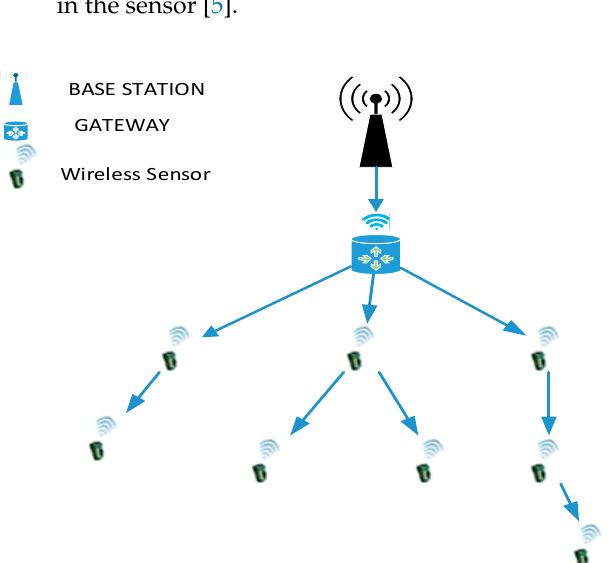
Figure 1. Architectural topologies of wireless sensor networks.